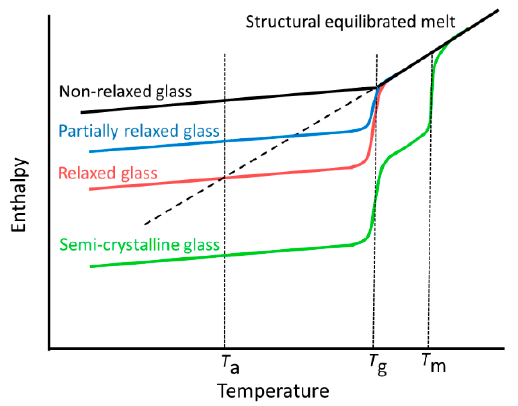
Figure 5. Sketch of the enthalpy–temperature behavior of differently annealed glasses at the annealing temperature T a .